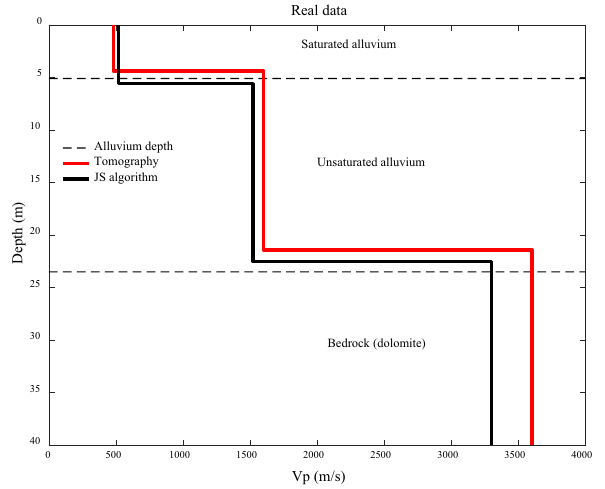
Fig. 8 Estimated Vp structure in the dam site by the JS inversion algorithm (black line) and tomography interpretation method (red line); also, interface of subsurface layers are represented by dashed